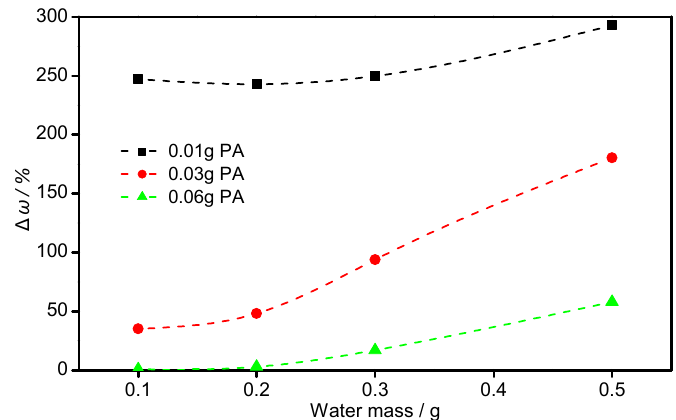
Figure 4. The relationship between ∆ ω and the dosage of water and polyacrylic acid (PAA).